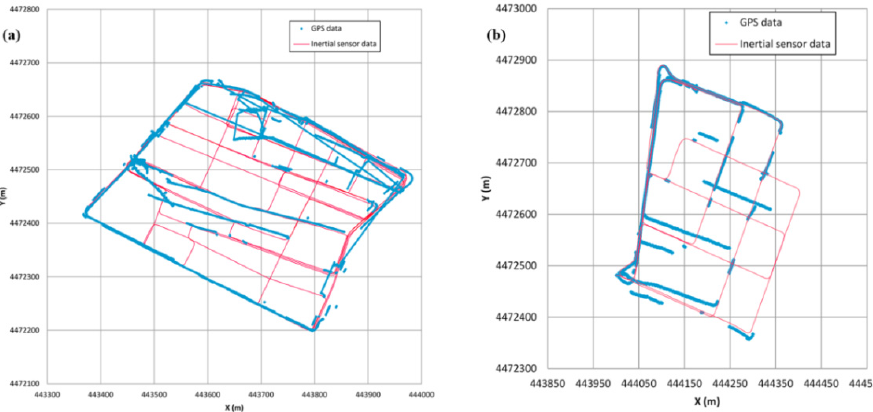
Figure 3. Data adjustment using inertial measurement system and GPS receiver. ( a ) Route 1, ( b ) Route 2.